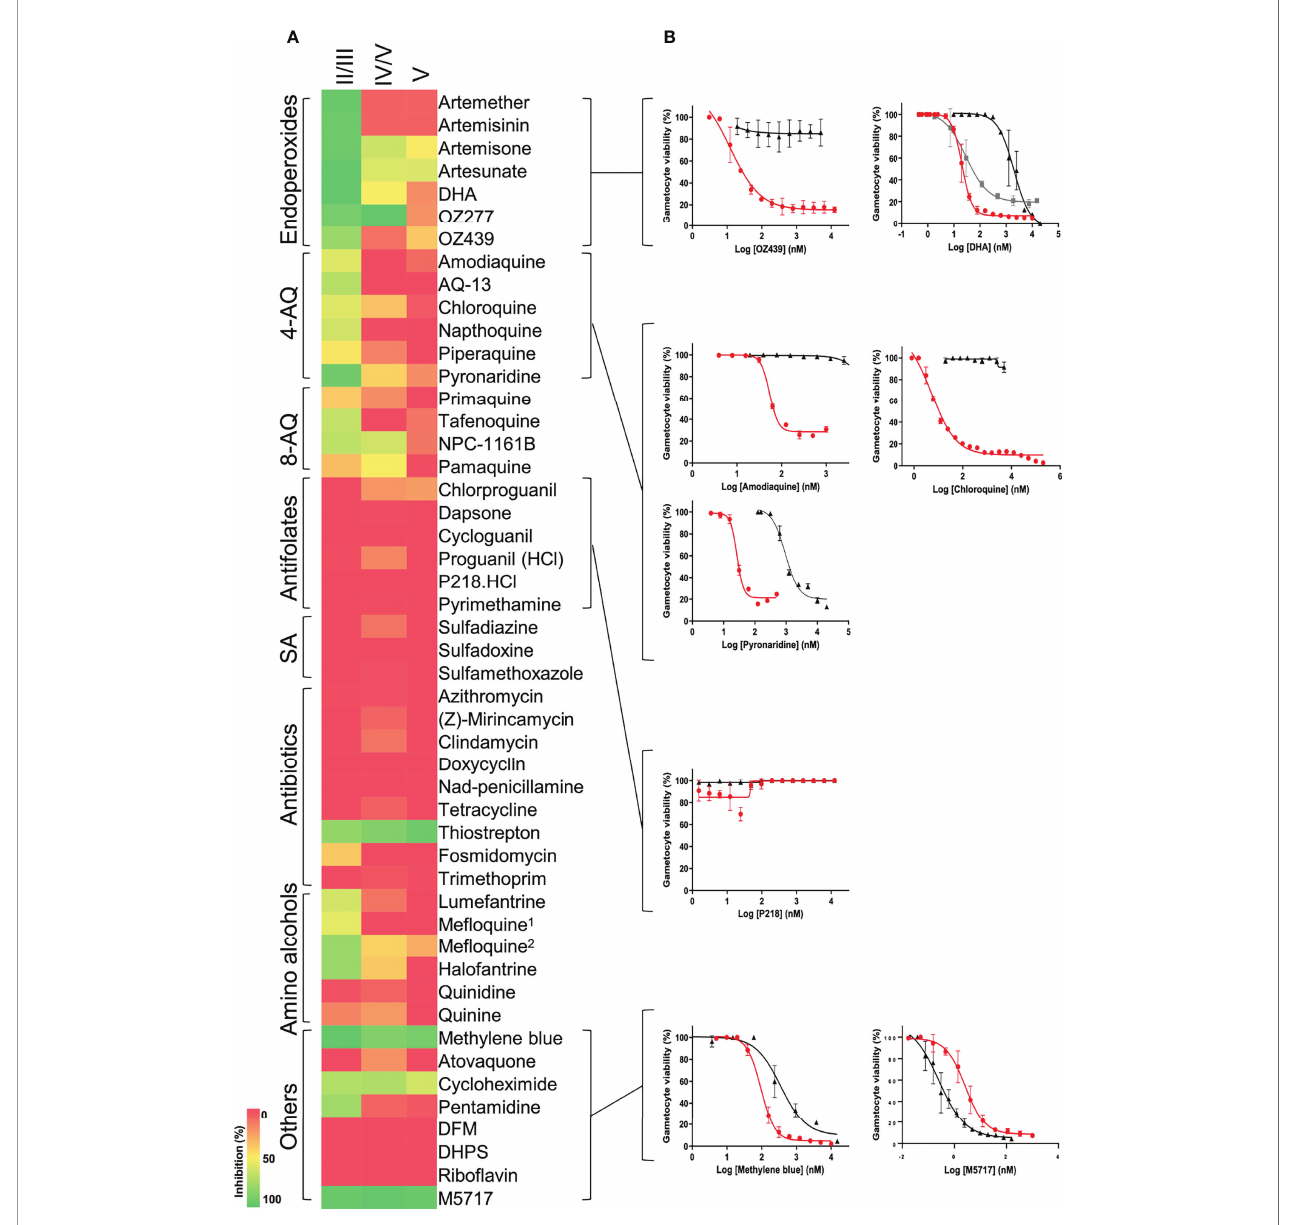
FIGURE 5 | Evaluation of gametocytocidal activity of key MMV compounds. (A) Gametocytocidal pro fi ling of the compounds (5 µM for 48 h) against immature (stage II/III), a mixture of stage IV and V and mature (stage V) gametocytes. (B) Dose-response curves of selected compounds indicating the IC 50 shift between immature (red), mature (black), and mixed stage IV and V gametocyte populations (gray). 1 Racemic, 2 (+RS); DFM, deferoxamine mesylate salt; DHPS, dehydroepiandrosterone sulphate. Data are from three independent biological repeats (n = 3), performed in technical triplicates, mean ± S.E